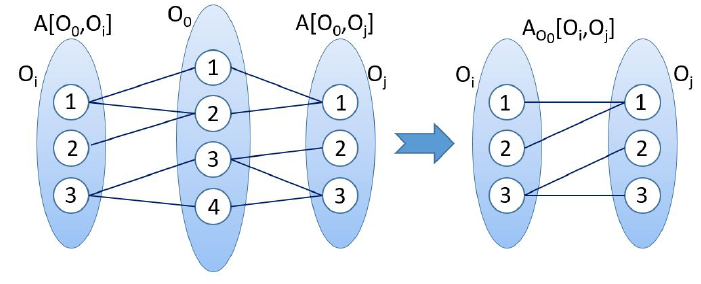
Figure 2. Projection of a property